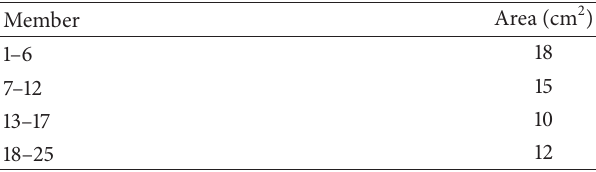
Table 4: Cross-sectional areas of truss elements.